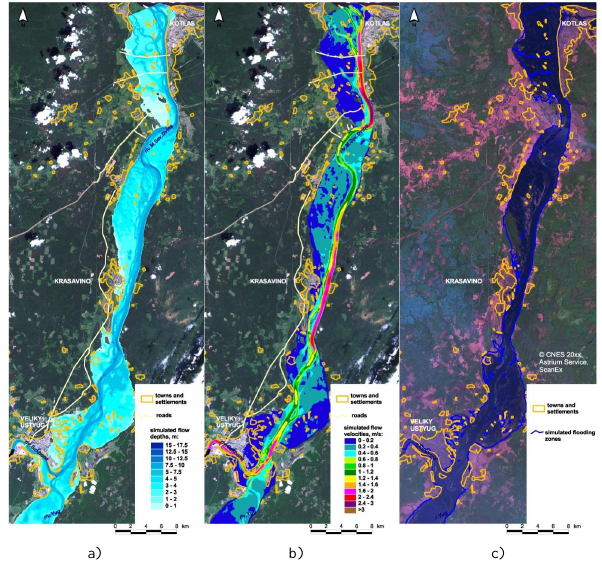
Figure 4. The values of depths (a) and flow velocities (b) of the Northern Dvina at 1% recurrence calculated using “STREAM-2D” model and the comparison of floodplain boundaries obtained by modeling and taken from space photographs from Spot5 satellite on 5 May 2012 (c)